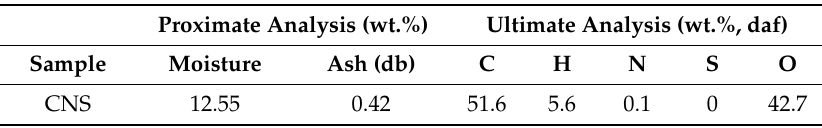
Table 1. Proximate and ultimate analyses of the raw (CNS).